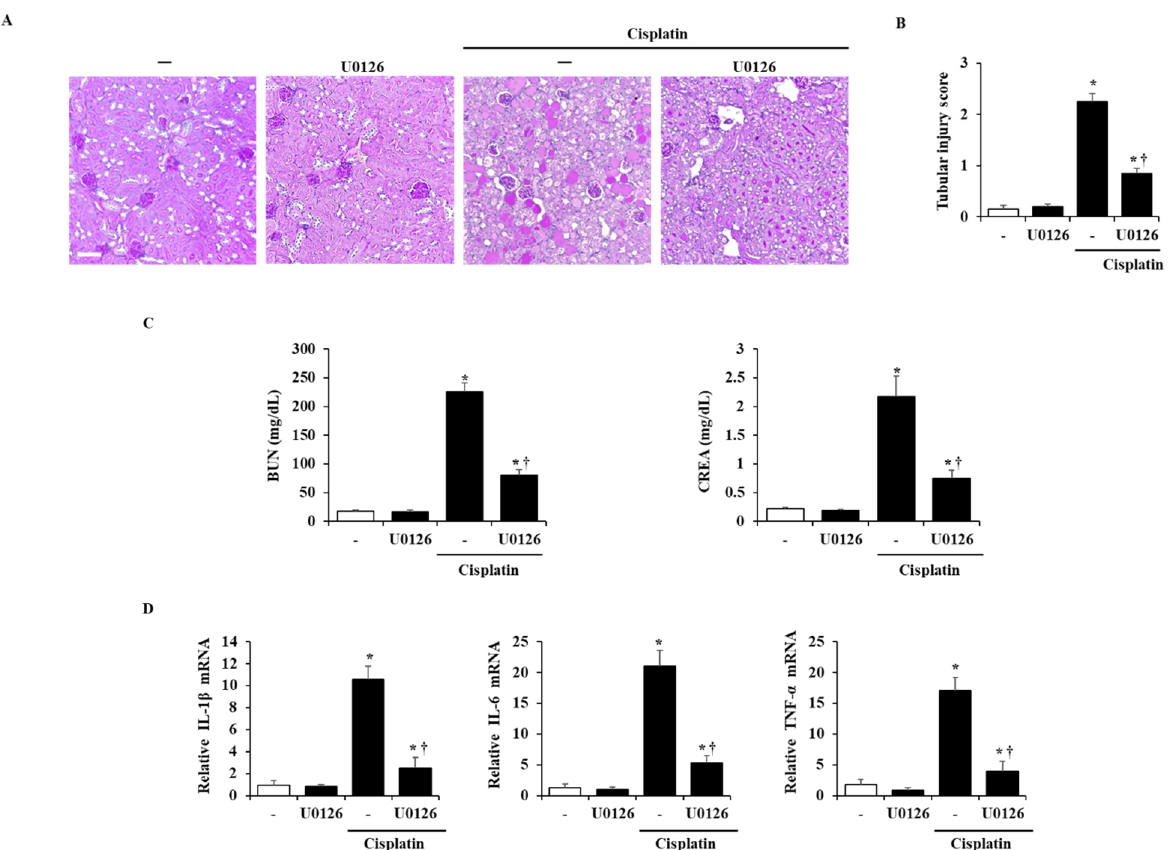
Figure 6. Effects of ERK 1/2 on the severity of cisplatin-induced AKI. Mice pretreated with U0126, ERK 1/2 inhibitor, (10 mg/kg) were administered with intraperitoneal injections of cisplatin (10 mg/kg). They were killed at 72 h after the cisplatin injection. ( A ) Representative PAS-stained sections of the kidney (200× magnification). ( B ) Histological sections of the kidney were scored from 0 (normal) to 4 (severe) for necrosis of tubule cells. ( C ) Serum BUN and CREA were measured at 72 h after cisplatin injection. ( D ) mRNA levels of IL-1 β , IL-6, and TNF- α were detected by real-time PCR. Each experiment was repeated 3 times. Data are represented as mean ± SEM ( n = 9). An * indicates p < 0.05 vs. saline-treated control group; † indicates p < 0.05 vs. cisplatin treatment alone. Scale bar = 20 μ m.